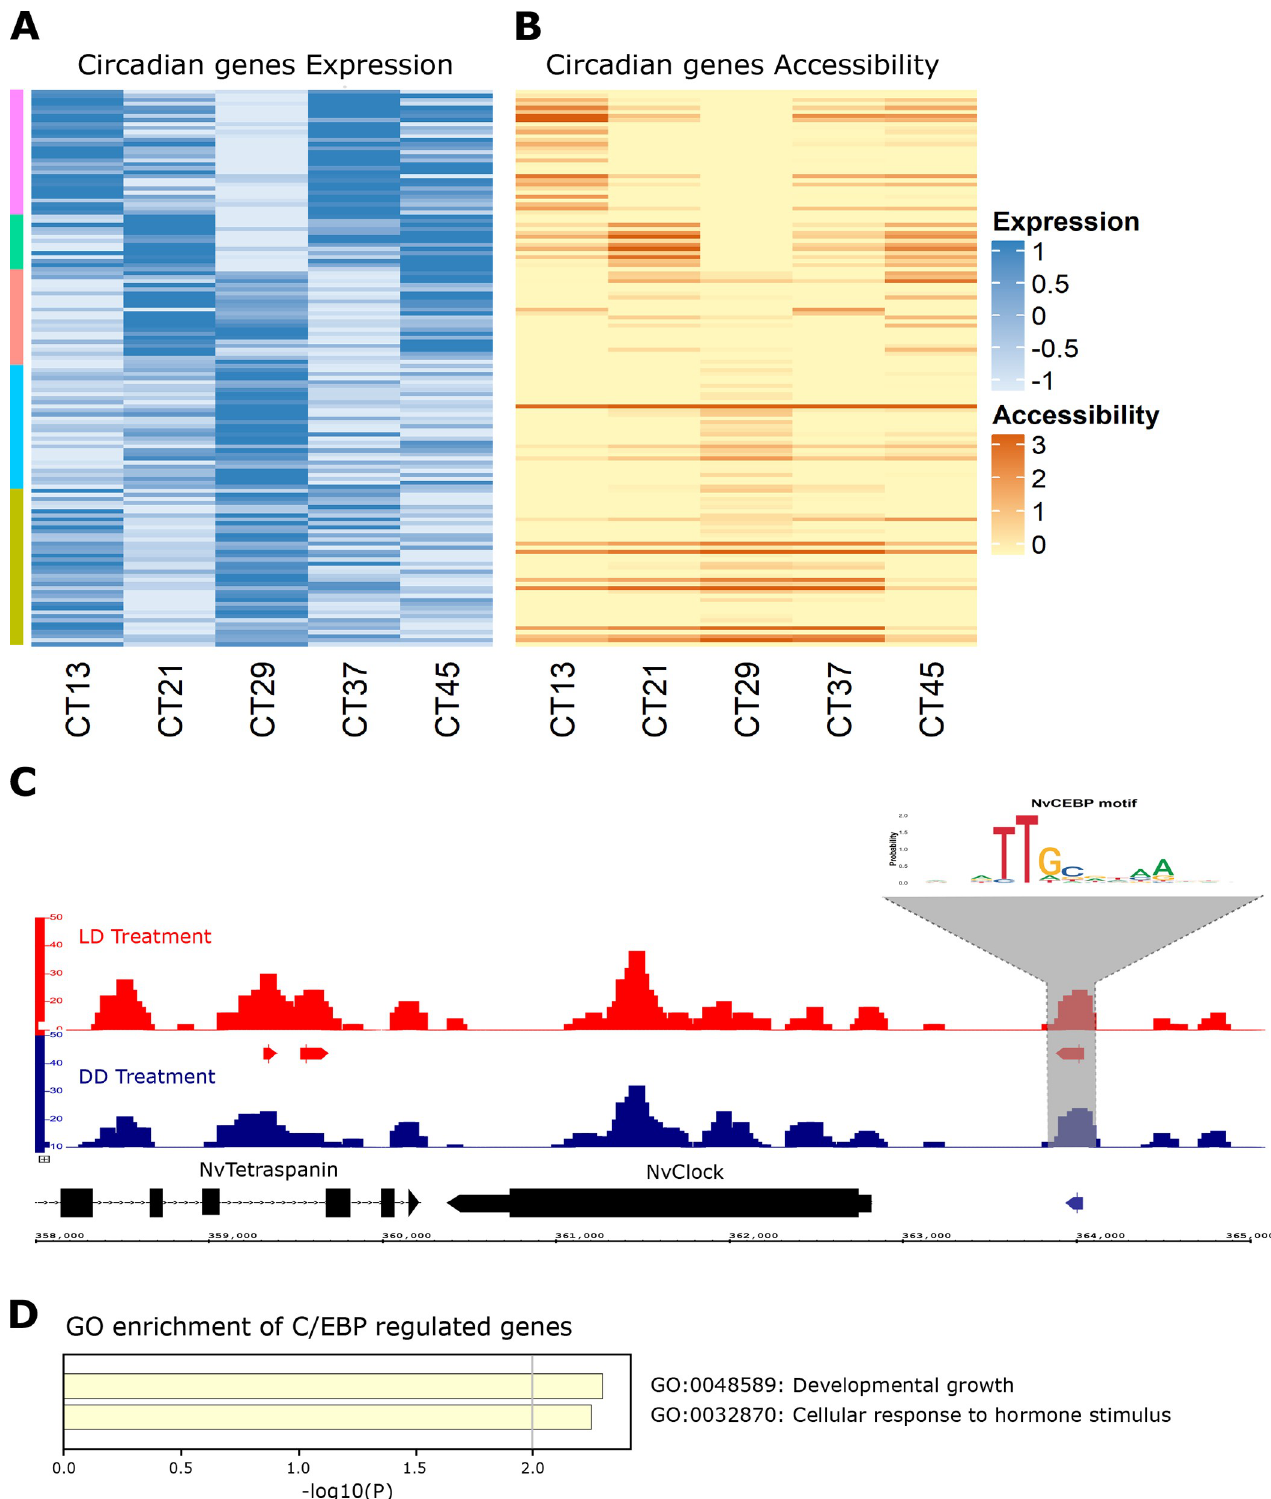
Fig 3. (A—B) 139 out of 180 genes that were found to be rhythmic in a previous RNA-seq experiment (Oren et al ., [15]) clustered by 5 expression groups and aligned to their accessibility score. RNA expression score is in -log 2 (fold-change) colored in blue in the range of -1 to 1. ATAC-seq accessibility score is in -log 2 (FPKM), colored in orange in the range of 0 to 3. (C) Browser view of peaks from two treatments (LD CT13 –red, DD CT13 –blue). LOGO graph